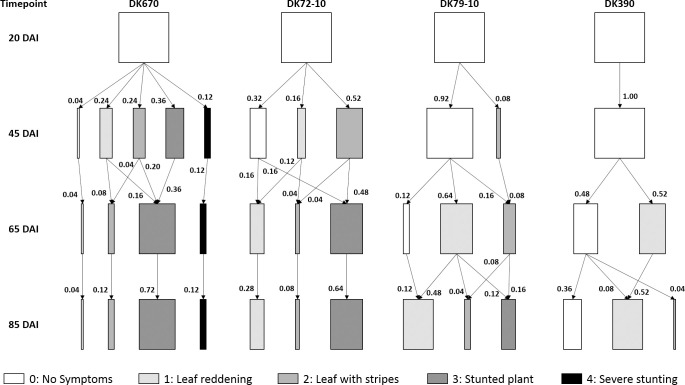
Kinematic diagram of the sequence of Corn Stunt symptoms.Four maize hybrids were inoculated at the four-leaf stage.